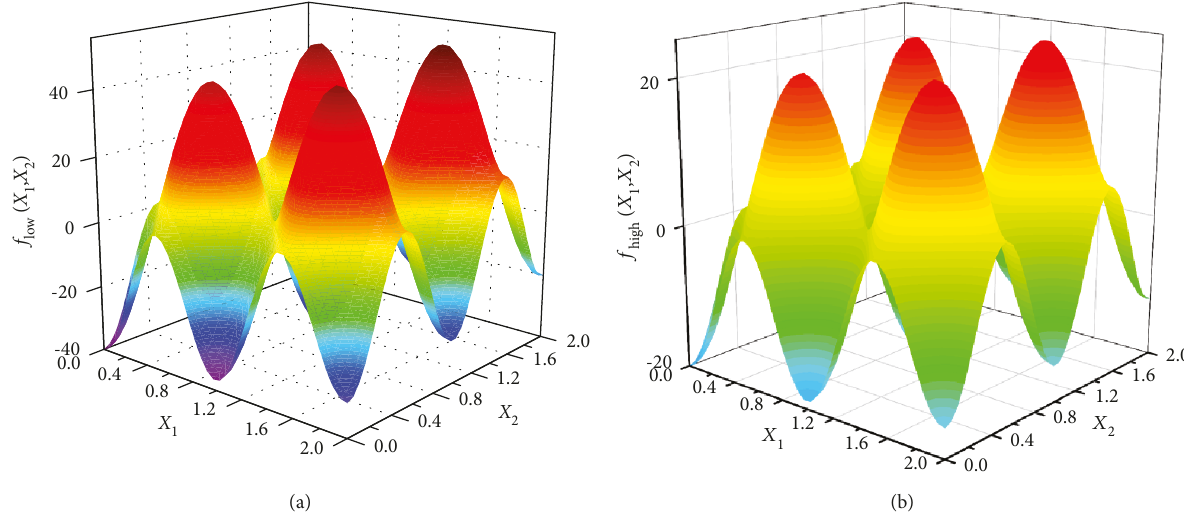
Figure 4: High and low LoF models: (a) low LoF model and (b) high LoF model.